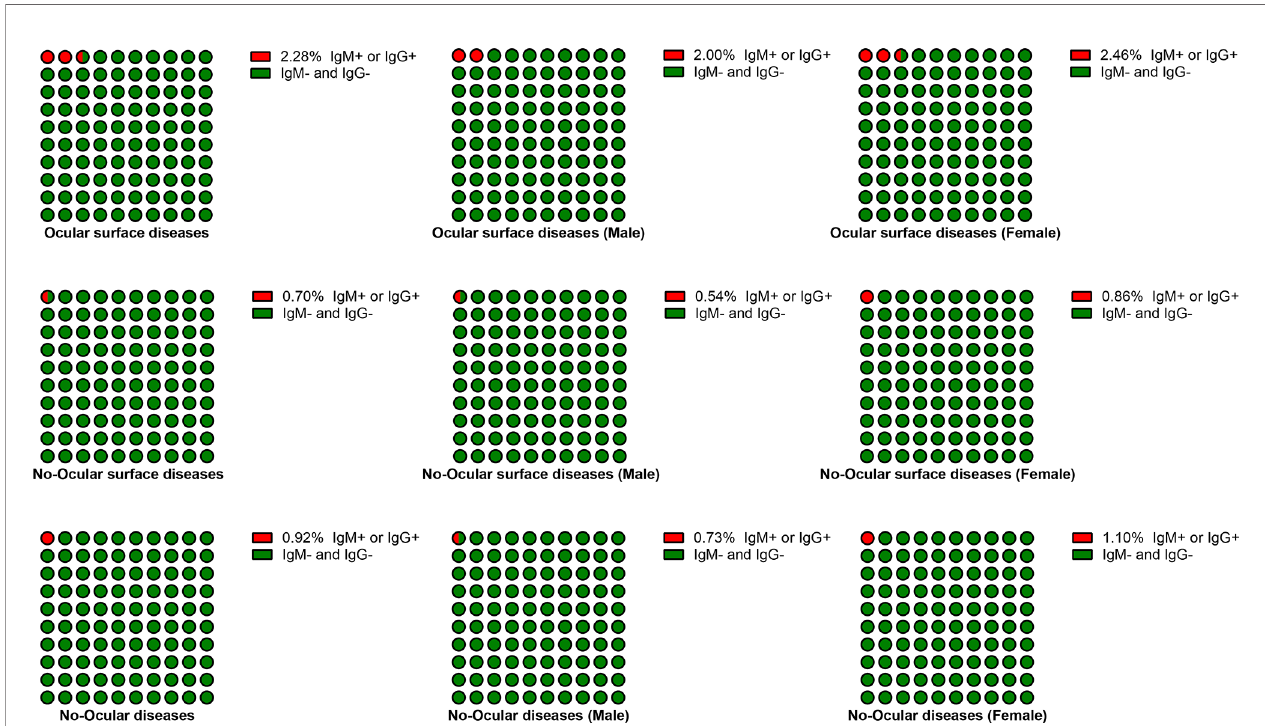
FIGURE 3 | The seroprevalence of antibodies to SARS-CoV-2 in male and female subgroup. Based on their sex, the subjects were categorized into male and female subgroup. The seroprevalence of antibodies to SARS-CoV-2 was particularly higher in ocular surface diseases compared with no-ocular surface diseases and no-ocular diseases in male and female